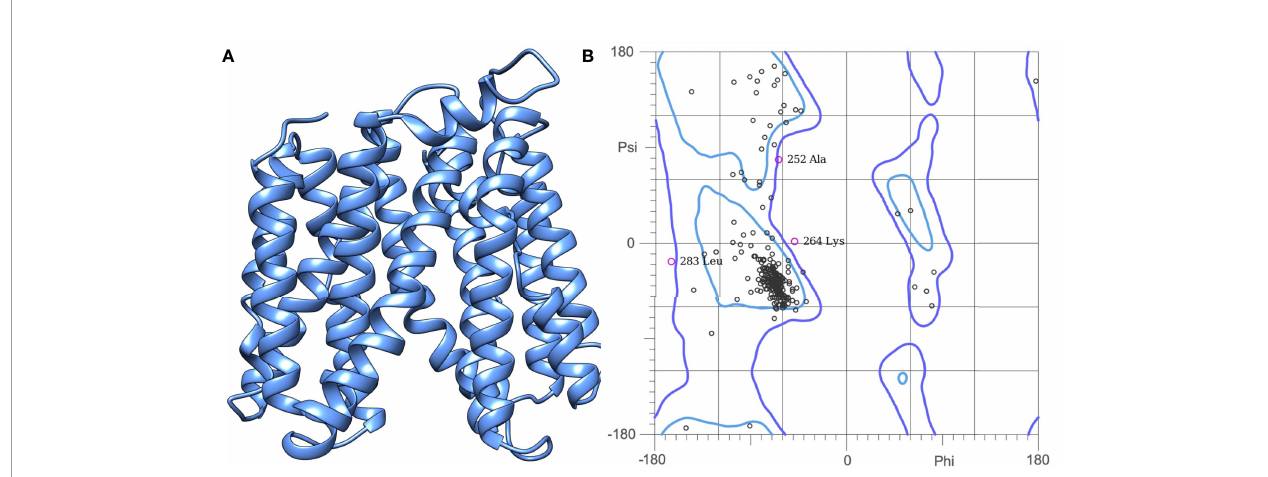
FIGURE 1 | (A) Construction of the NorA ef fl ux pump model: A three-dimensional model of NorA was generated using I-TASSER. The best scoring model (C-score = 0.43; TM Score = 0.70 ± 0.12) was visualized using UCSF Chimera. (B) Quality prediction of modeled NorA protein using the Ramachandran plot. The structure of NorA protein is found to span in the regions of beta-sheets and right-handed alpha helix. Phi and Psi represent the torsion